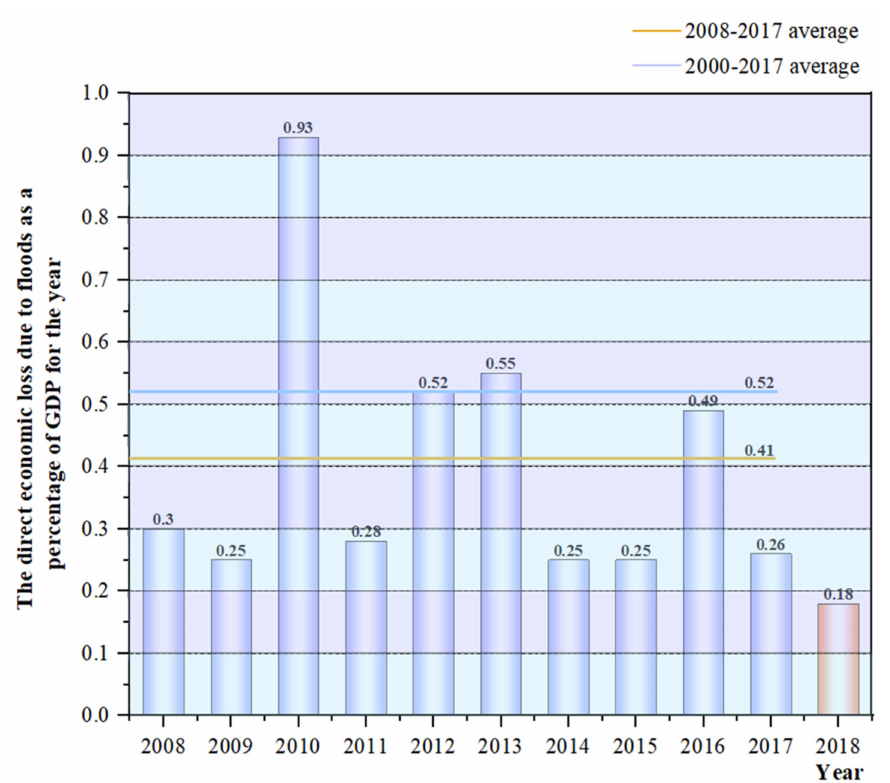
Figure 1. 2008–2018: China’s direct economic losses due to floods as a percentage of GDP for that year. Flood resilience captures the ability to thrive through flood events and recover from the disruptions occurred to the engineering assets [15]. Some scholars have defined the concept of flood resilience from different scales such as building units, cities, river basins, and regions (Table 1). The common point is that on the one hand, they emphasize the ability to withstand flood hazards, and on the other hand, they emphasize the ability to recover